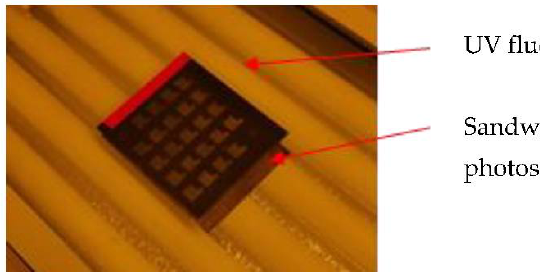
Figure 3. UV light exposure of PVDF sheet with both side photosensitive film coating .